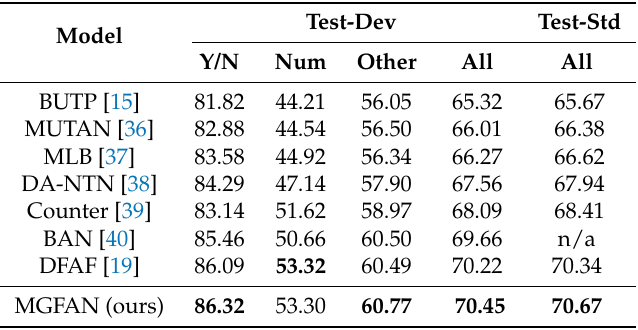
Table 2. Accuracies (%) of the single model on the test-devand test-stdsplits of VQA-v2. BUTP, bottom-up and